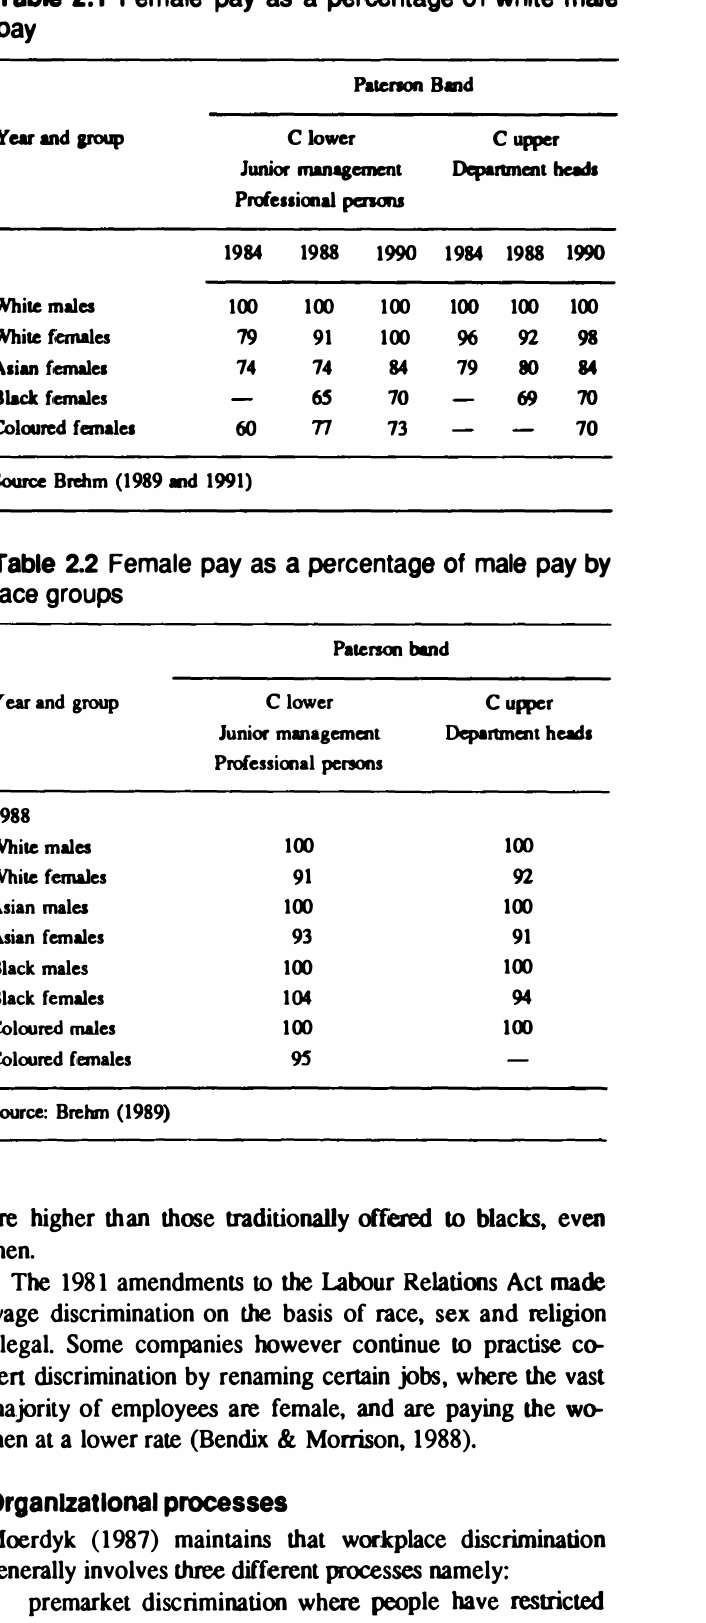
Table 2.1 Female pay as a percentage of white male pay